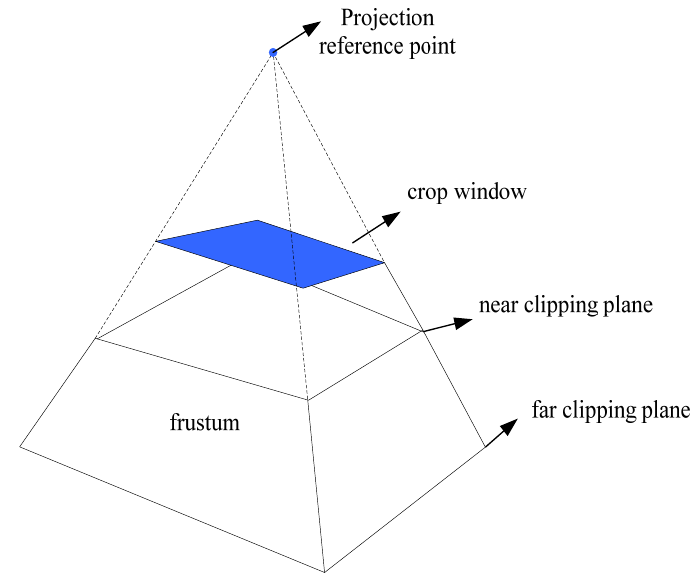
perspective short effect, and if the object is close to the observation surface, the projection effect would be enhanced. Objects close to the observation surface have a larger display area than distant objects of the same size. To achieve perspective projection transfor- mation, a frustum similar to the visual mode of the eye or camera can be used, as shown in Figure 6.